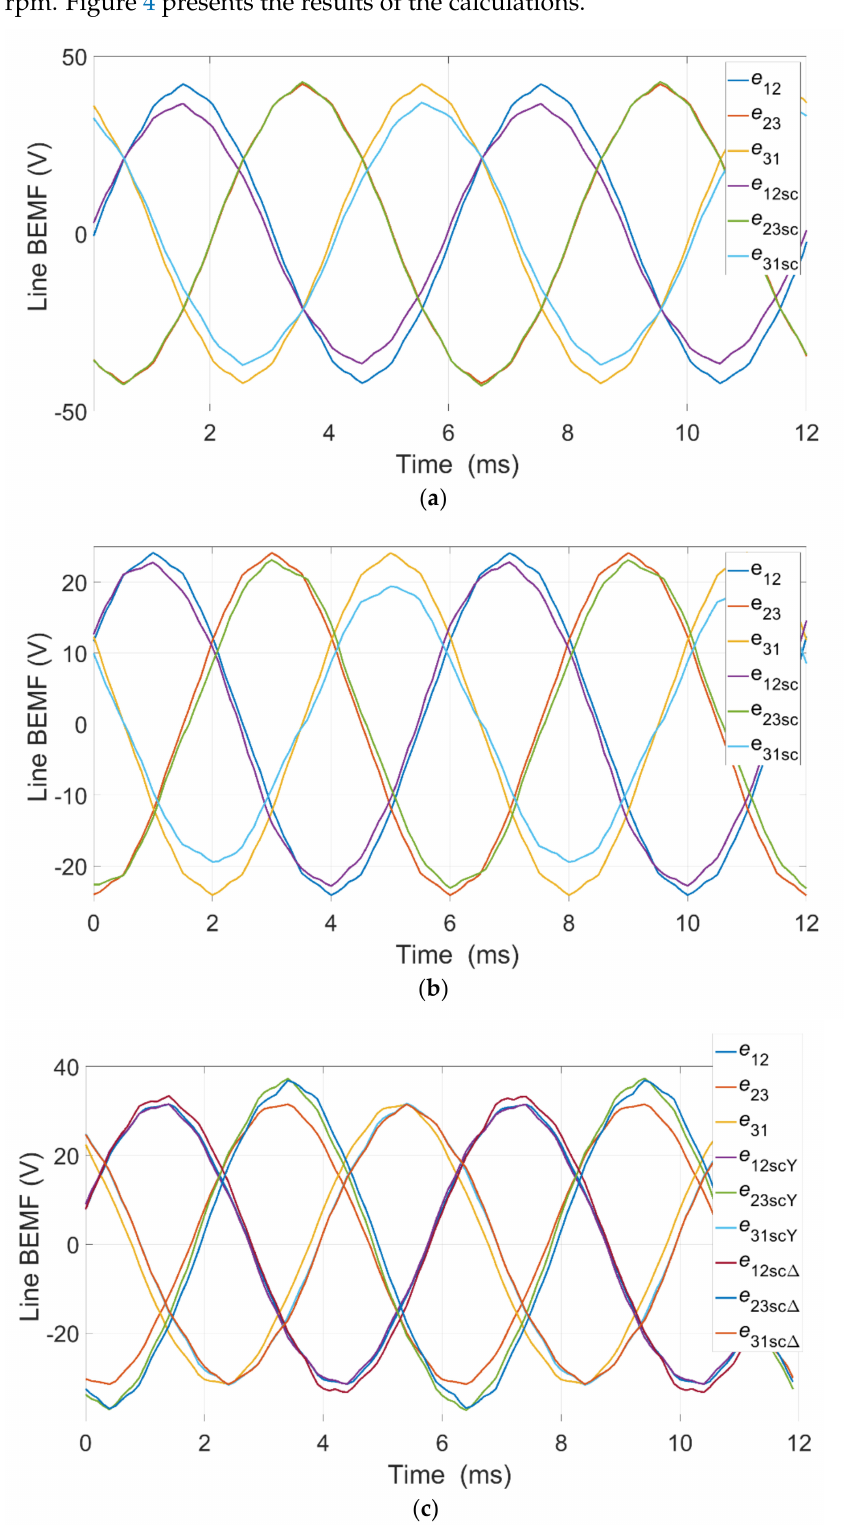
Figure 4. Induced voltages for particular configurations: ( a ) star, ( b ) delta, ( c )